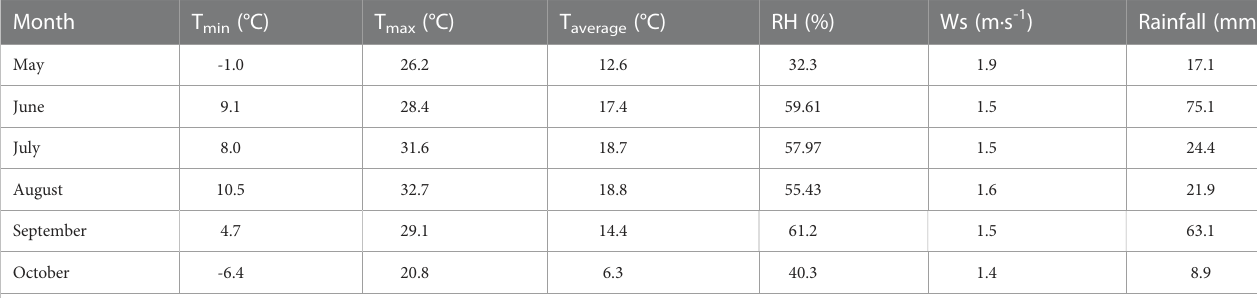
TABLE 1 The basic climatic information in